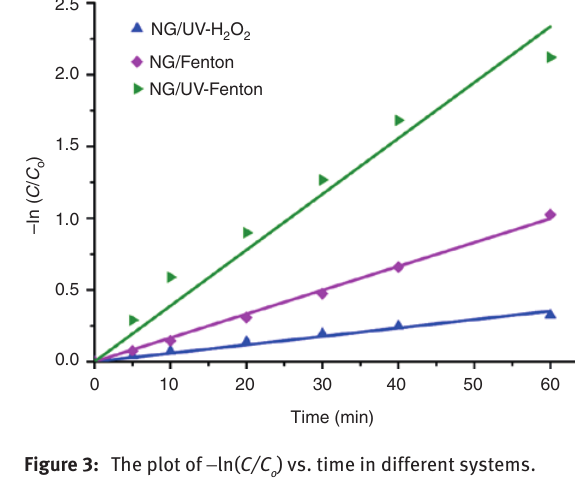
Figure 3: The plot of − ln( C/C